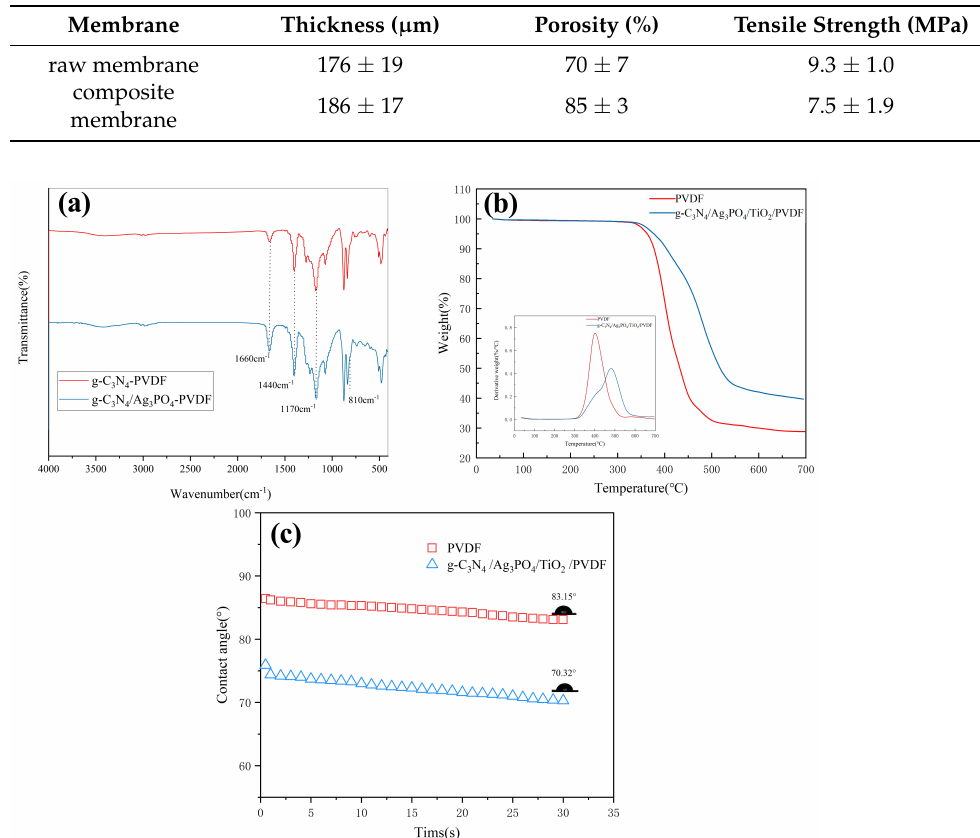
Figure 7. ( a ) FTIR analysis, ( b ) TGA curves, and ( c ) dynamic contact angle of the raw PVDF and g- C 3 N 4 /Ag 3 PO 4 /TiO 2 /PVDF membranes.